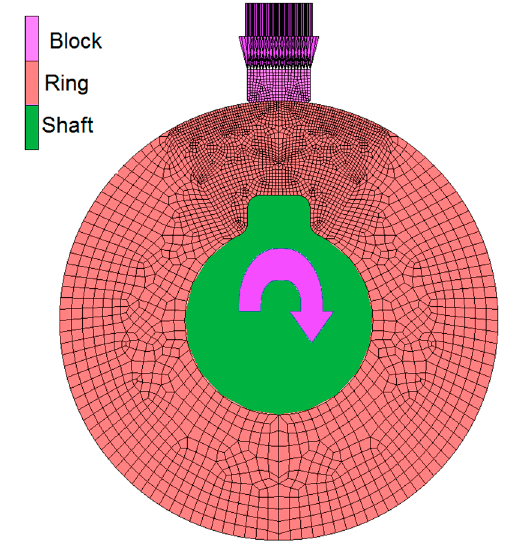
Figure 9. Mesh for the block ‐ on ‐ ring system.